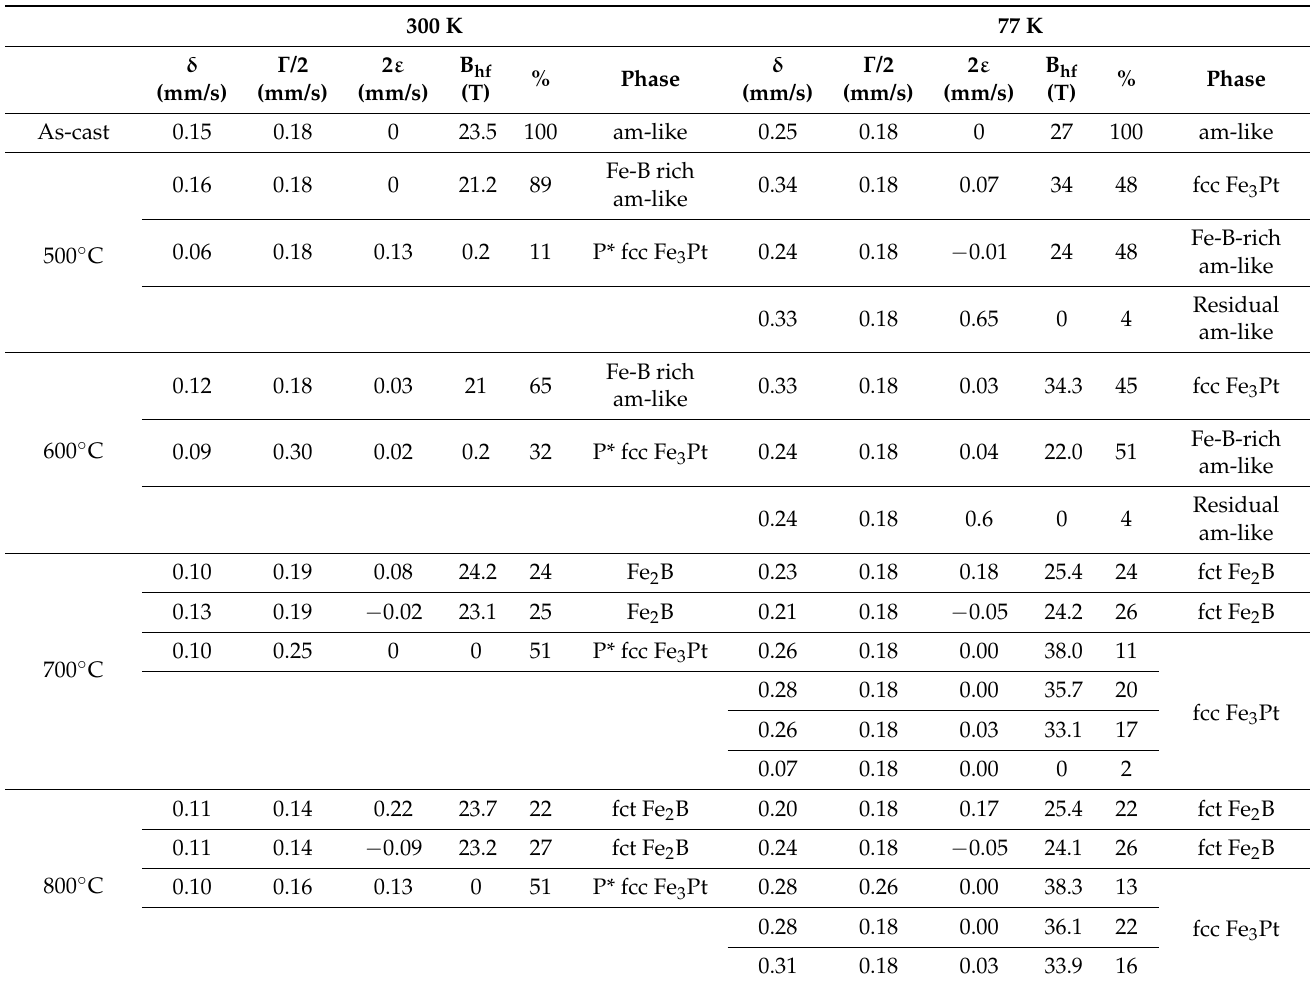
Table 2. Hyperfine parameters obtained from the fitting of the 300 K and 77 K Mössbauer spectra. δ is the isomer shift, Γ /2 is the half width at half maximum (HWHM) of the line, 2 ε is the quadrupolar splitting, and Bhf is the hyperfine